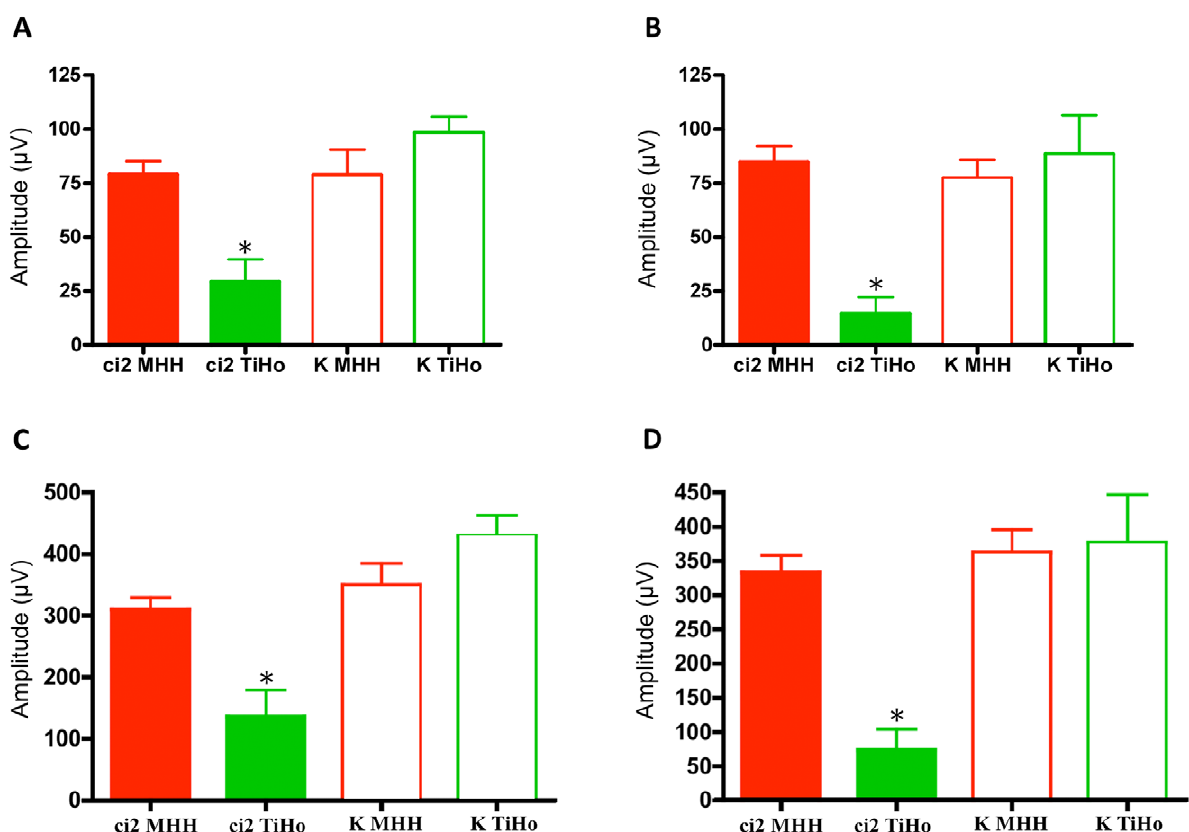
Figure 2. Mean values of rod responses recorded by electroretinography. Average skotopic a- and b-wave maximum amplitudes elicited by a 3 cds/m 2 light stimulus. ( A ) a-wave amplitudes of the left eyes of LEW/Ztm- ci2 (ci2) rats from two different hygienic units, MedSchool (MHH) and VetSchool (TiHo) and corresponding controls (K) ( B ) a-wave amplitudes of the right eyes ( C ) b-wave amplitudes of the left eyes ( D ) b-wave amplitudes of the right eyes; responses of ci2 mutants of the VetSchool group are strongly increased compared to controls and mutant rats of the MedSchool group *significant differences compared to controls p , 0.05 are indicated with an asterix.